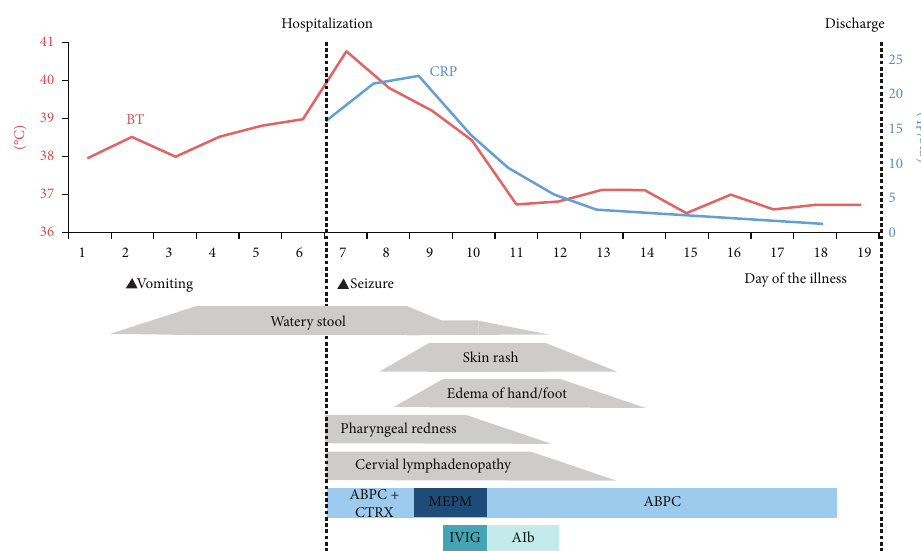
Figure 1: Clinical course of the patient. BT, body temperature; CRP, C-reactive protein; ABPC, ampicillin; CTRX, ceftriaxone; MEPM, meropenem: IVIG, intravenous immunoglobulin; Alb,